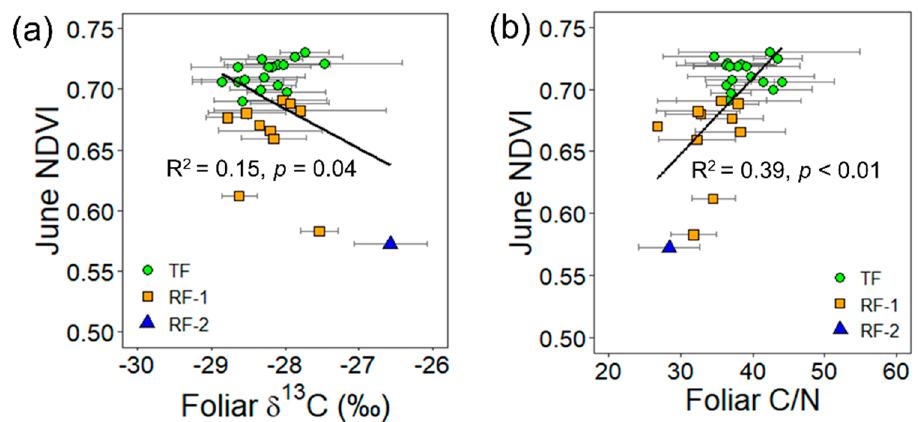
Figure 7. Relationships between the NDVI on 4 June 2018, the δ 13 C ( a ) and the C/N ( b ) at each plot for the TF ( n = 17), the RF-1 ( n = 10), and the RF-2 ( n = 1). Horizontal error bars represent standard deviations. Black solid line shows the linear regression line for all plots in the transect. Table 2. Linear regression models between the plot NDVI which were calculated from the Landsat- 8 OLI images on 4 June, 31 July, 7 August, 23 August, and 17 September (independent variables) and the plot-averaged δ 13 C, δ 15 N, and C/N of the larch needles sampled (dependent variable x). Models were described by the R-squared and p value. Number of plots used in the models is 28 out of 34: with the TF ( n = 17), the RF-1 ( n = 10), and the RF-2 ( n = 1). Foliar δ 13 C (‰) Foliar δ 13 N (‰) Foliar C/N